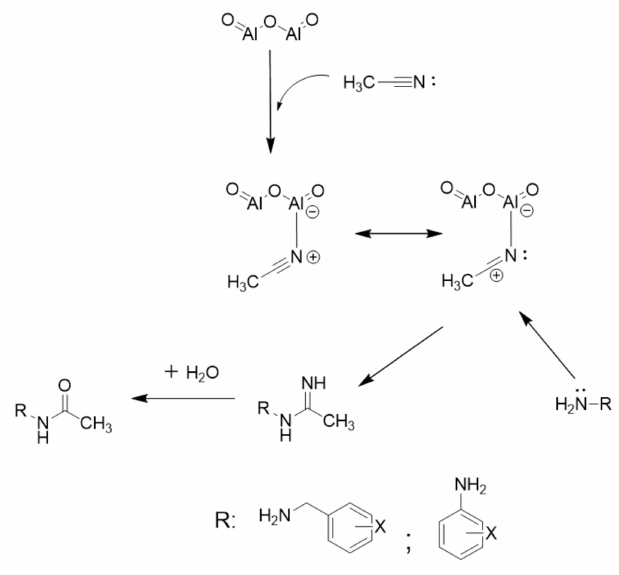
Scheme 1. The suspected reaction mechanism of